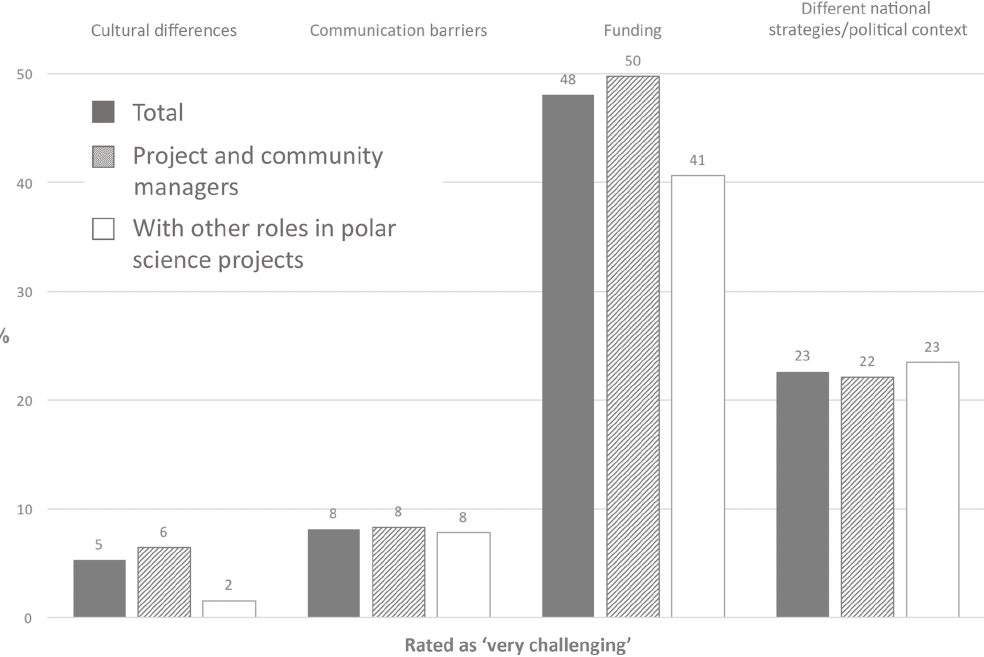
Figure 6. Challenges associated with international cooperation in polar science projects. Survey respondents (%) rating as “5 – very chal- lenging” when asked the question Q10: 10. (International) cooperation: Please rate (from 1 to 5) the following challenges.